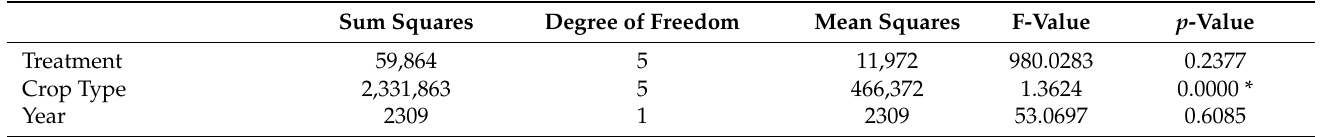
Table 2. Summary of the Factorial ANOVA testing for main and interactive effects of different treatments on the total biomass of several crops type during a two-years